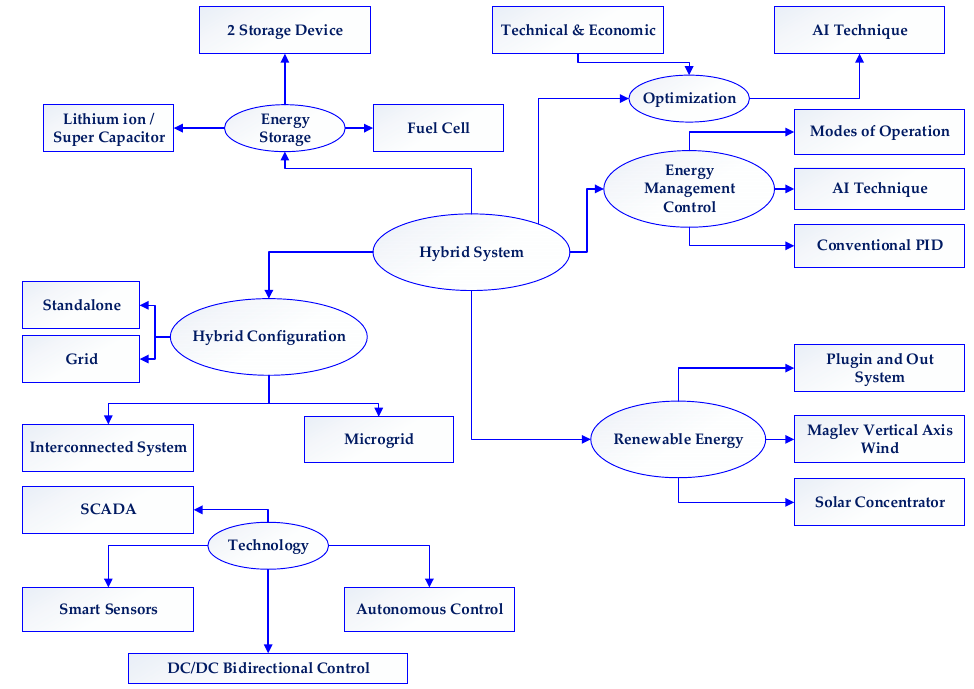
Figure 2. Constructional architecture of yybrid RE-DPG with ESS.